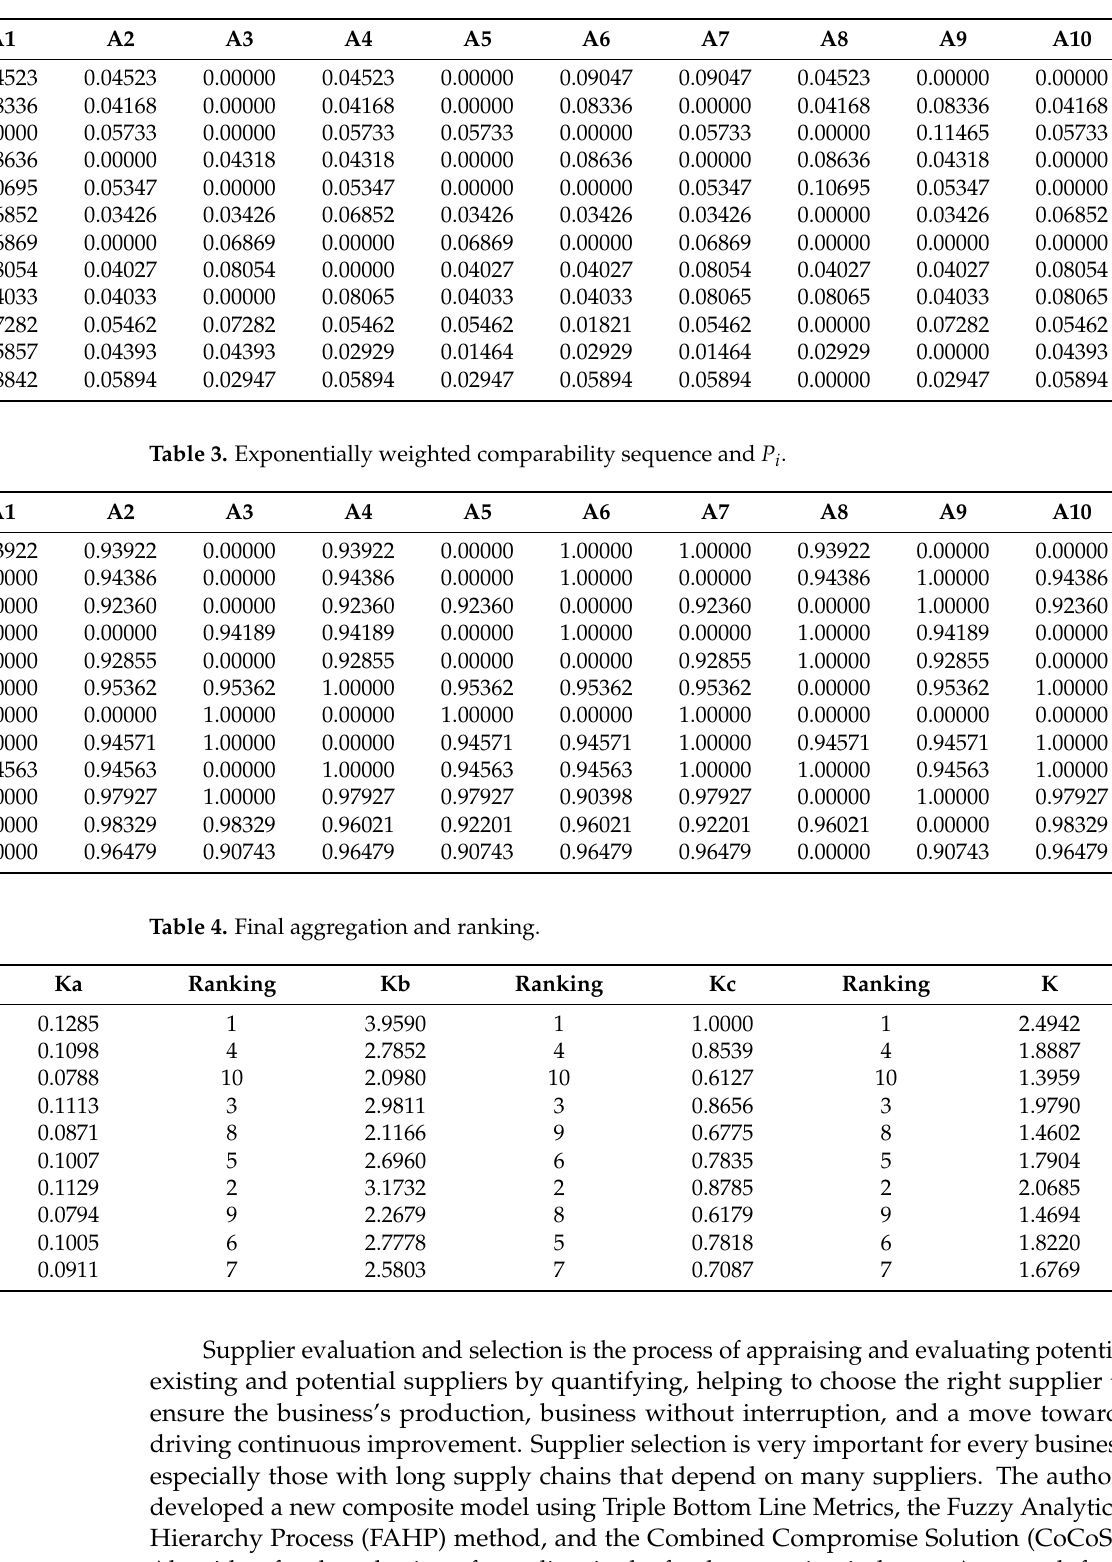
Table 2. Weighted comparability sequence and S i .